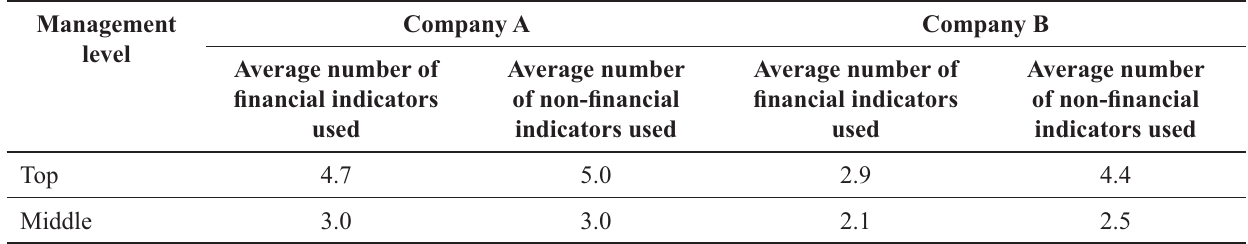
Table 6. Usage of fi nancial vs non-fi nancial PI by top and middle level